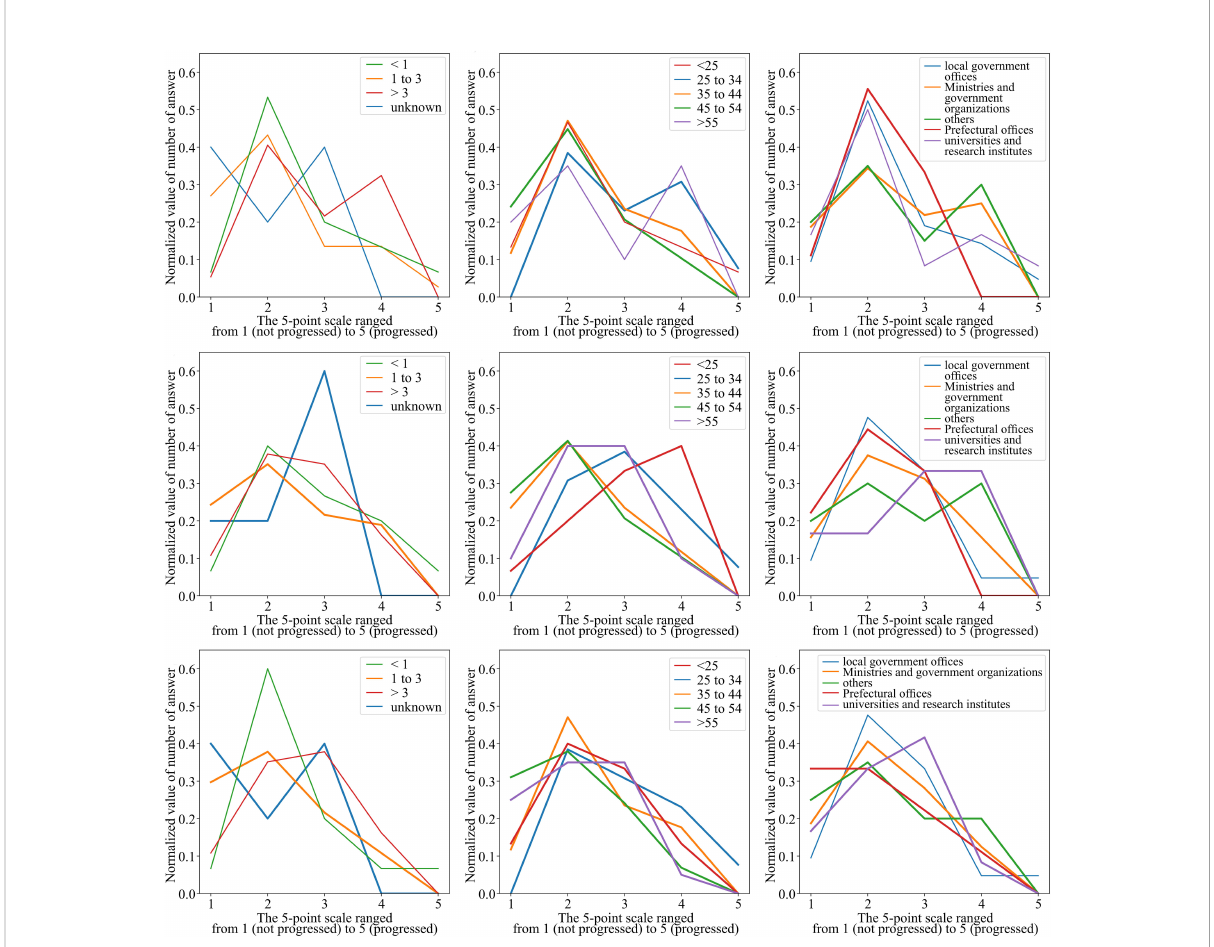
FIGURE 2 Results on the progress of marine carbon-related efforts grouped by attributes. For each of the three questions (each row), the results are shown for each of the three respondent attributes (each column). The questions are “ understanding the roles and effects of marine carbon ” (left column), “ maintenance of the marine carbon ecosystem ” (center column), and “ dissemination and promotion of marine carbon ” (right column). The respondent attributes are “ the number of they had known about marine carbon ” (top row), “ age ” (center row), and “ organization ” (bottom